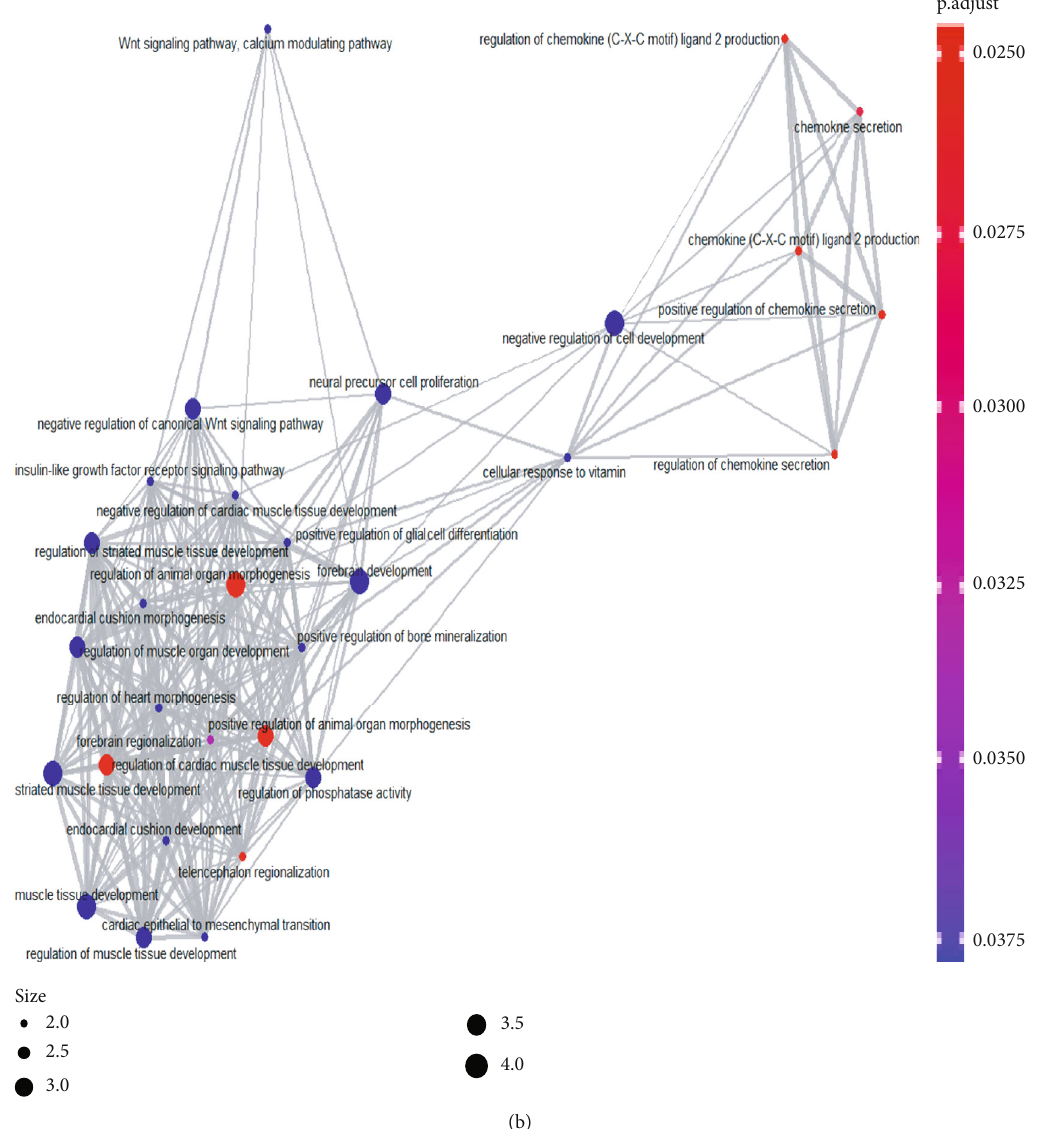
Figure 3: GO and KEGG enrichment analysis results: (a) count number, gene ratio, and adjusted p value of common DEGs; (b) the interaction relationship of the GO and KEGG